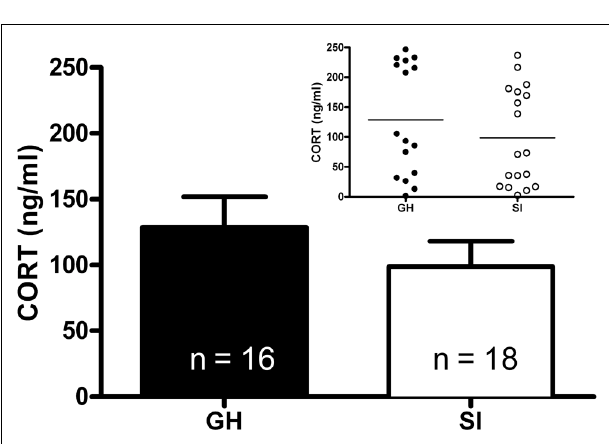
exploring vertically than group housed (GH) rats [main effect of group, F (1,407) = 4.949, # p < 0.05]. * p < 0.05 vs. GH rats at that timepoint; #SI vs. GH rats.